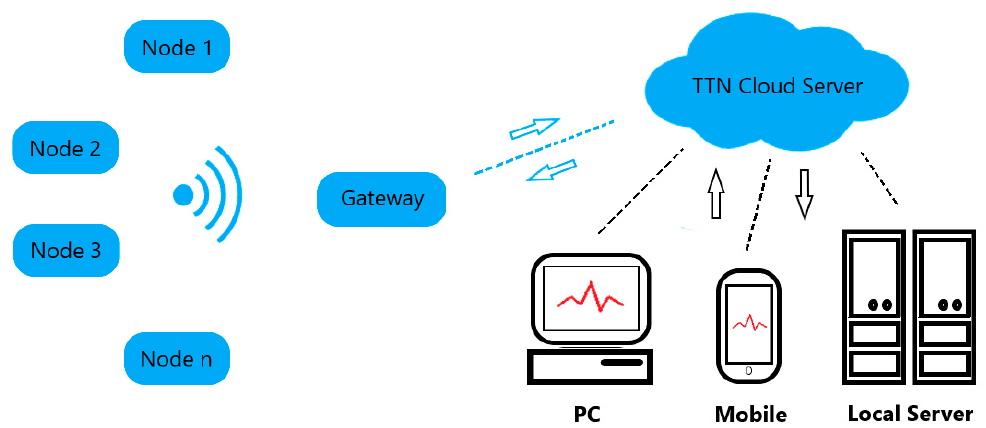
Figure 1. LoRa (short for long-range) sensor network operation scheme.